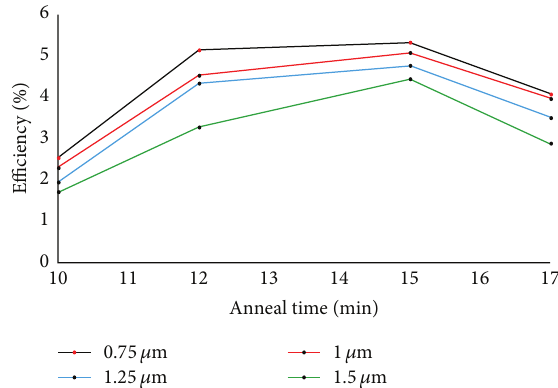
Figure 5: Plot of maximum solar cell efficiency versus CdCl 2 anneal time, which were all obtained at a CdTe thickness of 0.75 𝜇